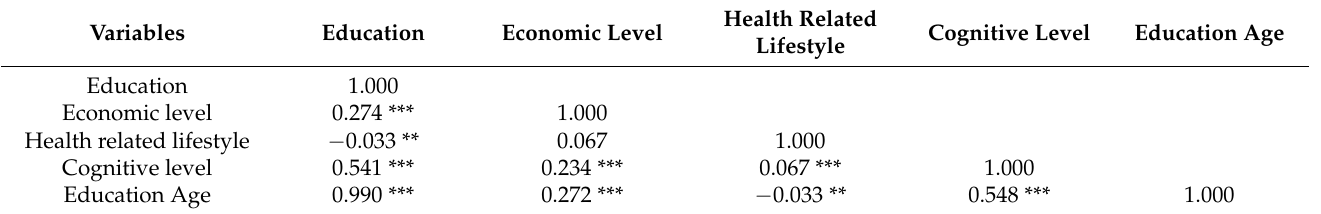
Table 4. Correlation tests for key variables.